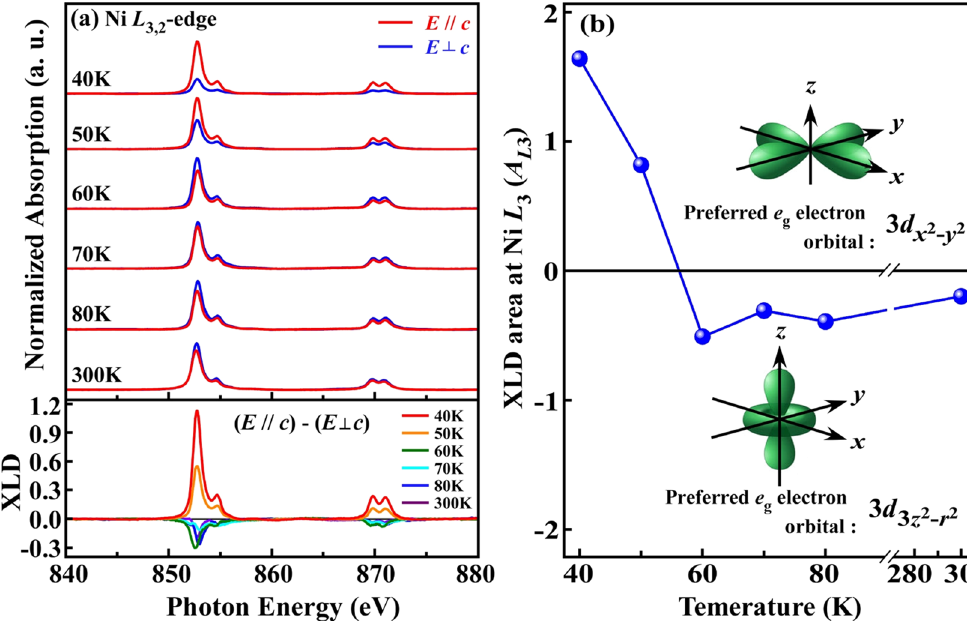
Figure 5. ( a ) Temperature-dependent Ni L 3,2 -edge X-ray absorption spectra obtained using linearly polarized X-rays with E // c and E ⊥ c polarizations, with the corresponding XLD [( E // c ) − ( E ⊥ c )] shown at the bottom. ( b ) Temperature-dependent variation in the XLD area (integrated over the range of 847–857 eV of the XLD spectra) at the L 3 -edge ( A L 3 ), shown to elucidate the thermal evolution of the preferential electron occupancy in the Ni 3 d e g orbital, which switches from in-plane (3 d x2 − y2 ) to out-of-plane (3 d 3z2 − r2 ) above T SO (60